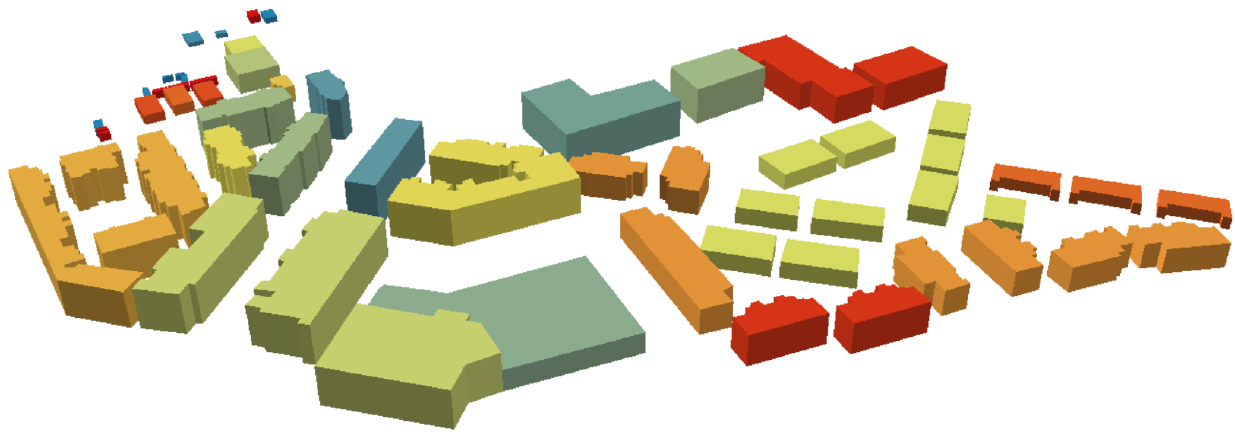
Figure 6. 3D city model represented in color scale in relation to height generated in GIS software.